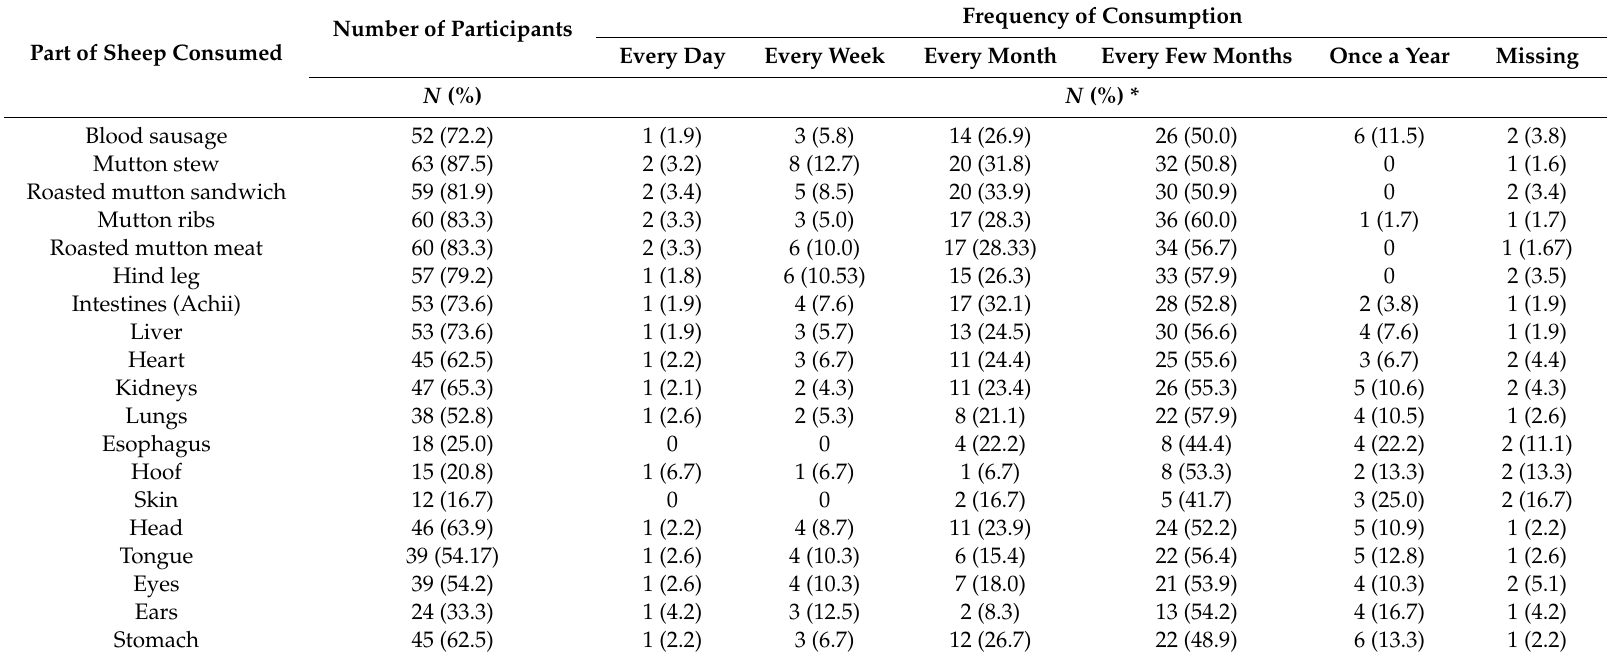
Table 5. Frequency of consumption among participants who completed the sheep survey, 2017 ( n =